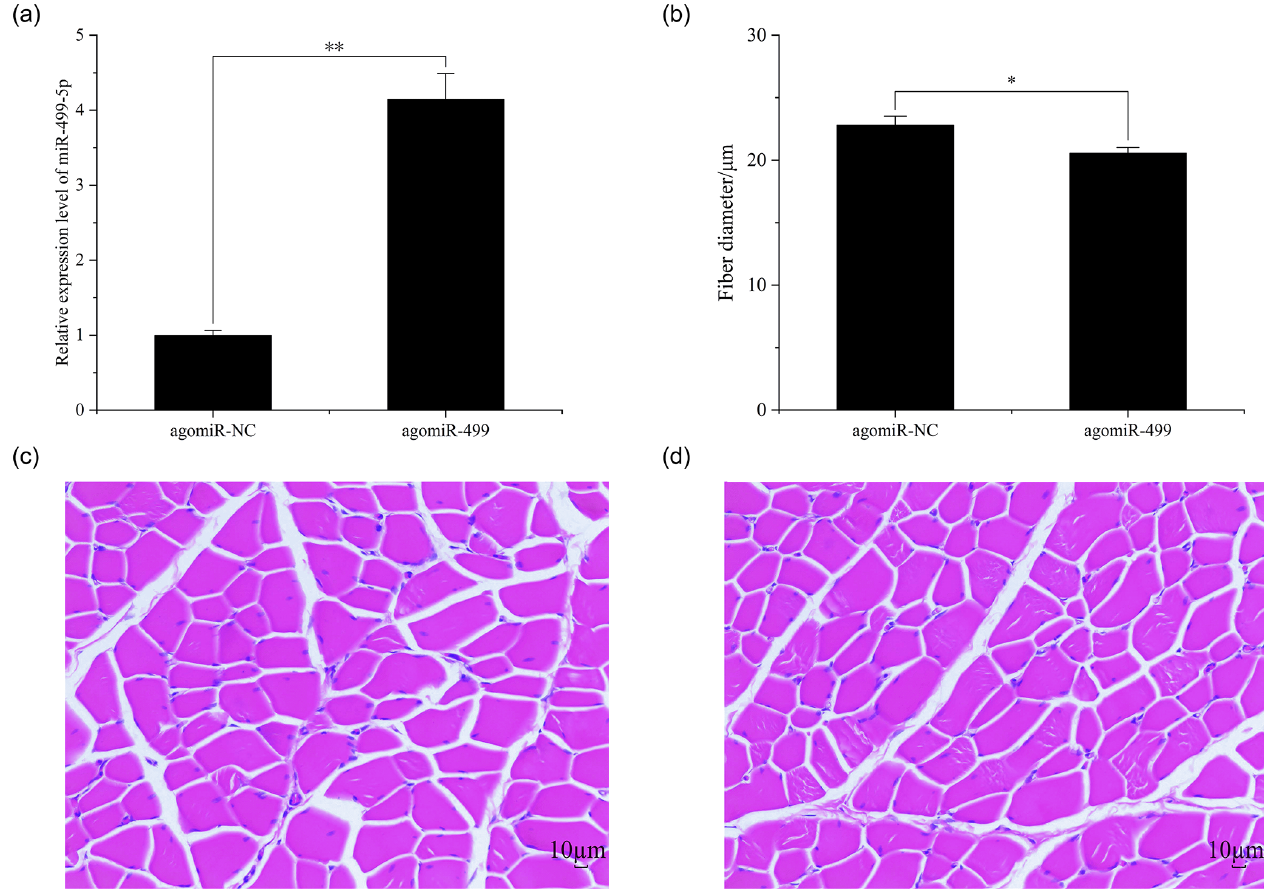
Figure 2. The muscle fiber in the control group (CG) and treatment group (TG). (a) The expression of miR-499-5p in the TG and CG. (b) The diameter of muscle fiber in the CG and TG. (c) HE staining of gastrocnemius in the CG. (d) HE staining of gastrocnemius in the TG. Statistical significance is indicated by ∗ P< 0 . 05. The agomiR-NC and agomiR-499 represent the control and treatment groups, respectively.